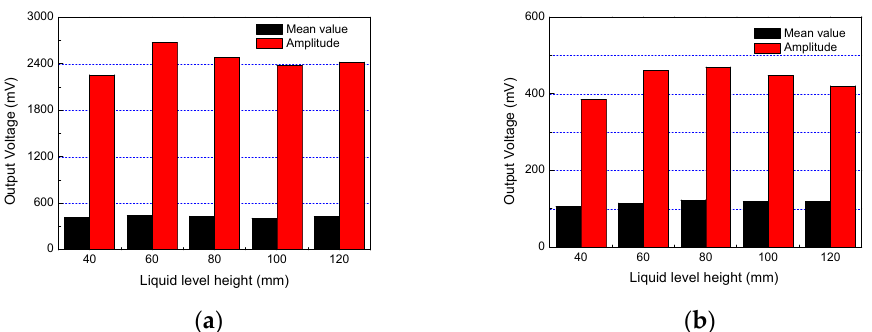
Figure 5. Bar graph of the hybrid energy harvester output voltage information: ( a ) Piezoelectric transducer; ( b ) Electromagnetic generator.